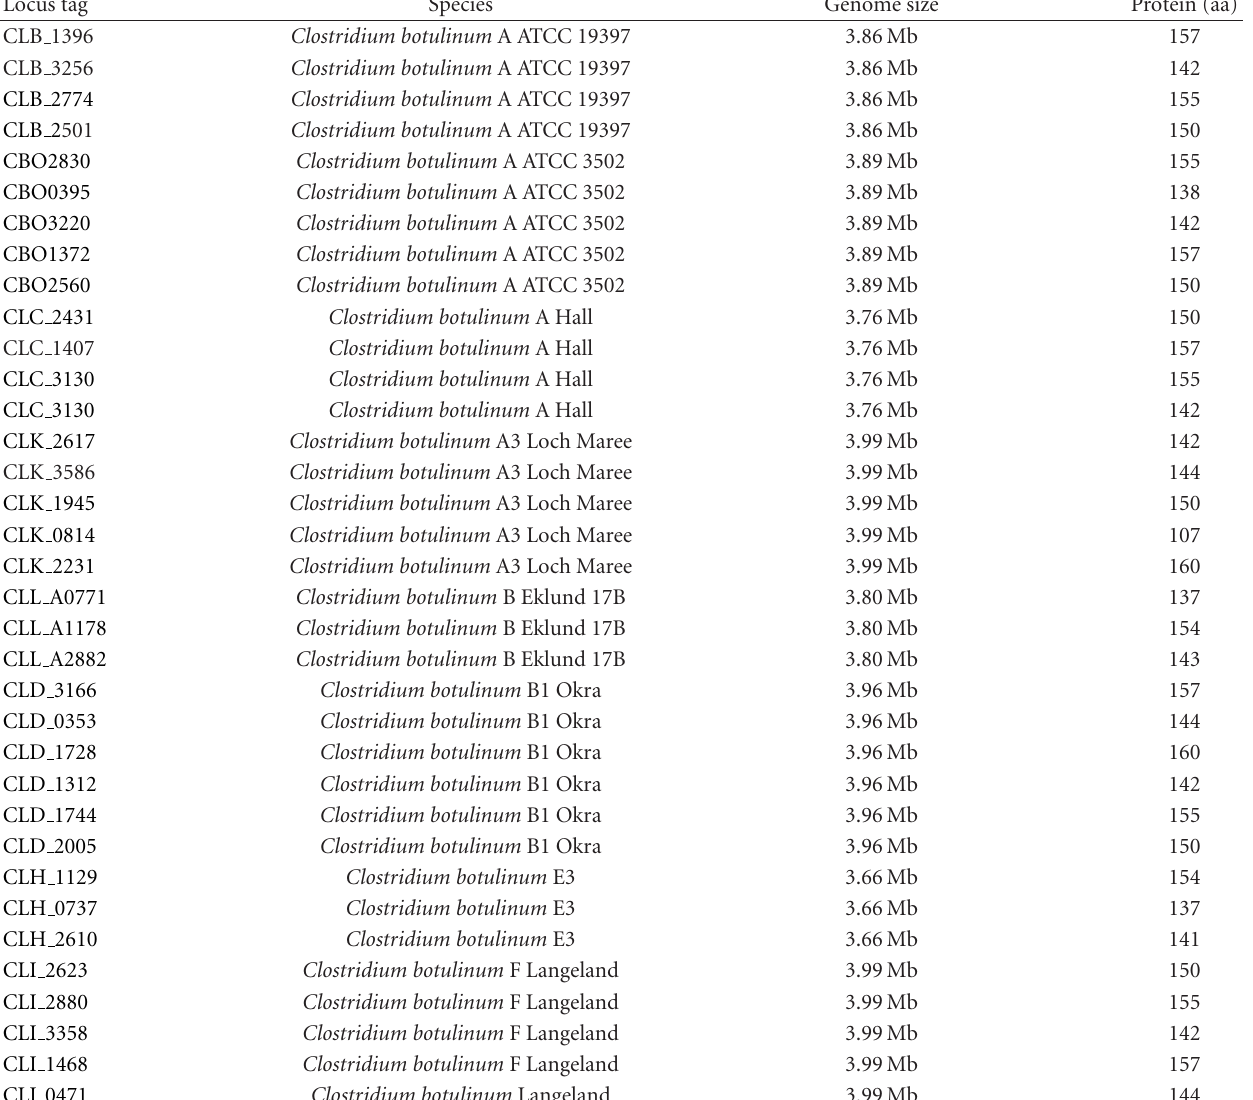
Table 1: The distribution of Fur in Clostridium